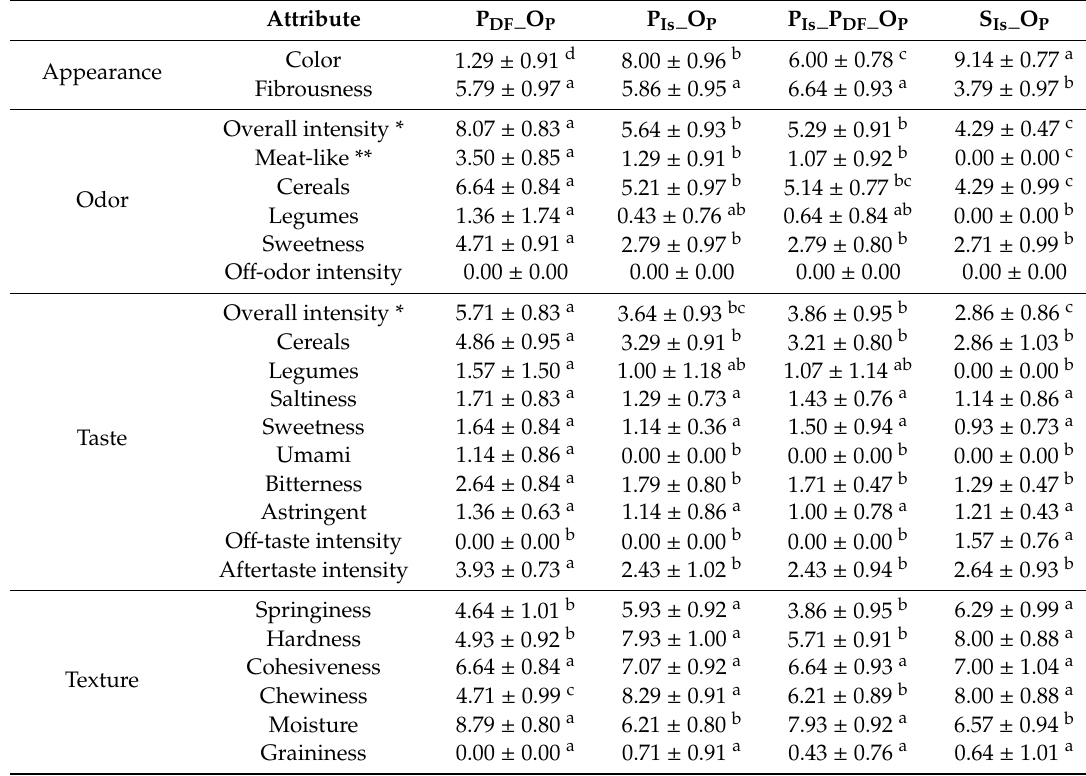
Table 6. Sensory analysis of meat analogues. P DF _O P : dry-fractionated pea protein and oat protein; P Is _O P : pea protein isolates and oat protein; P DF _P Is _O P : dry-fractionated pea protein, pea protein isolate, and oat protein; S Is _O P : soy isolates and oat protein. P DF _O P P Is _O P S Is _O